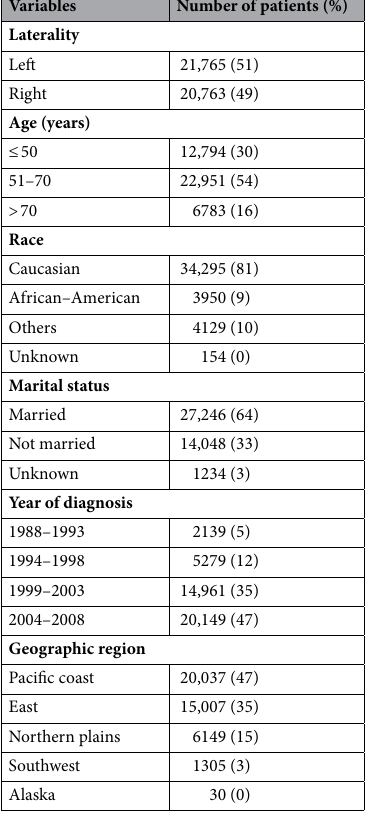
Table 1. Baseline clinical characteristics of the study population (N =